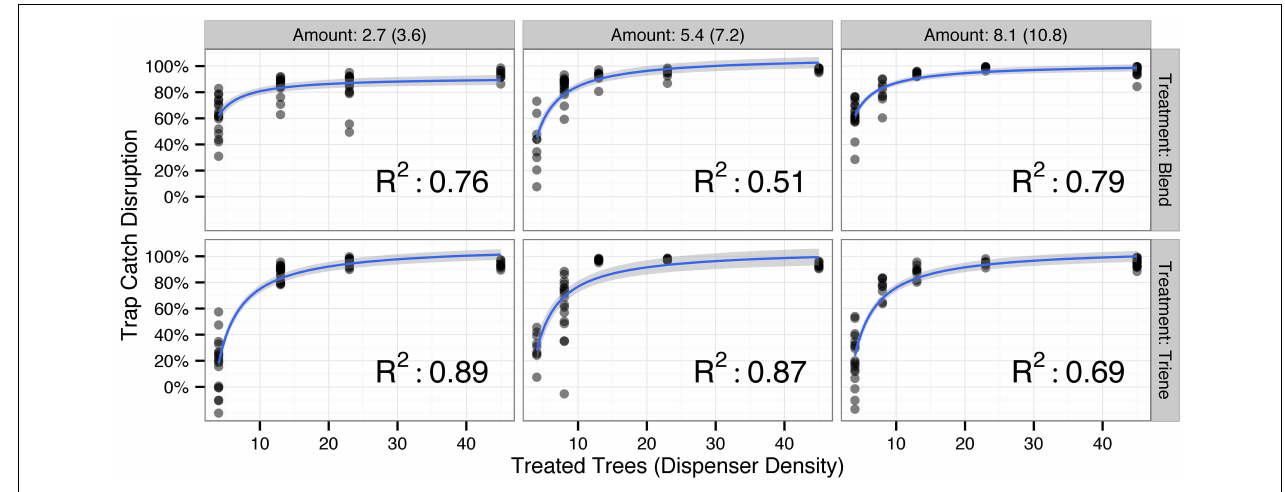
exponential decay model of the form Trap Catch 1 Treated Trees with p -values < 0.0001 and R 2 -values Disruption ∝ e depicted in the lower right corner of each plot. Points denote raw data; blue lines and shaded gray area denote model fit and model standard error